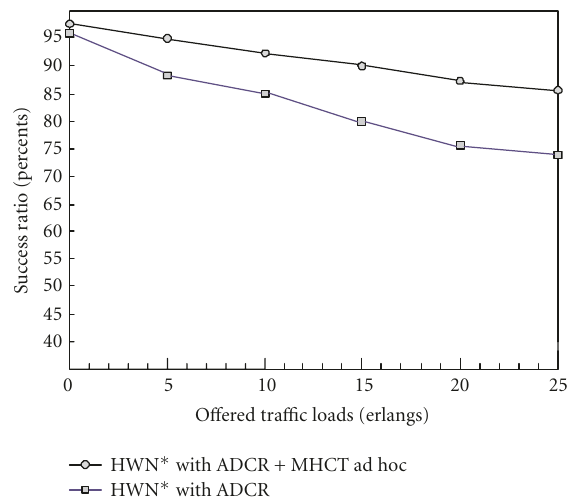
Figure 15: Comparisons of success route acquire ratio between HWN ∗ ADCR and HWN ∗ ADCR + MHCT ad